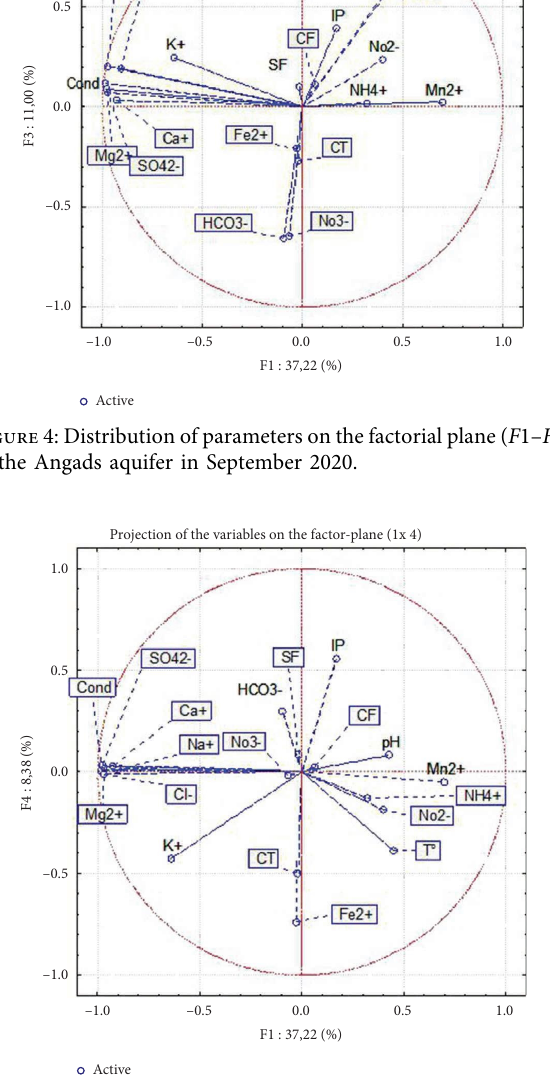
Figure 5: Distribution of parameters on the factorial plane ( F 1– F